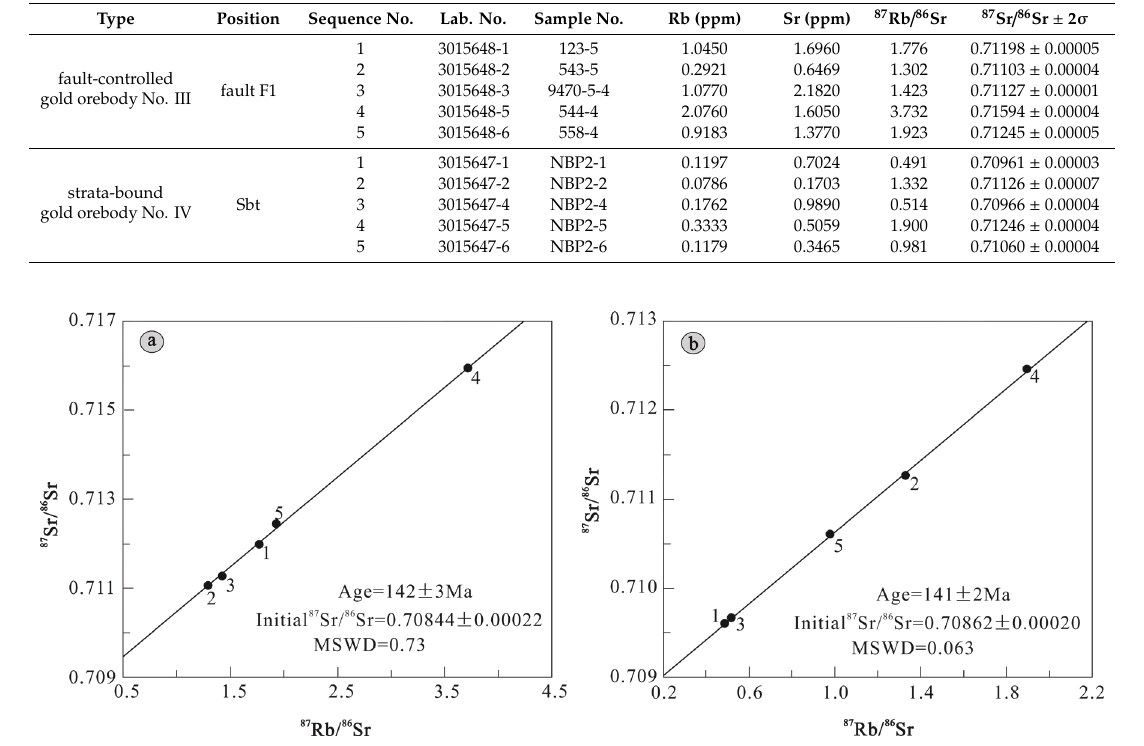
Figure 7. Rb–Sr isotope isochronic ages of quartz from the Nibao gold deposit for ( a ) fault-controlled gold orebodies and ( b ) strata-bound gold orebodies. The numbers (1–5) are meaning the sequence No. in Table 1.